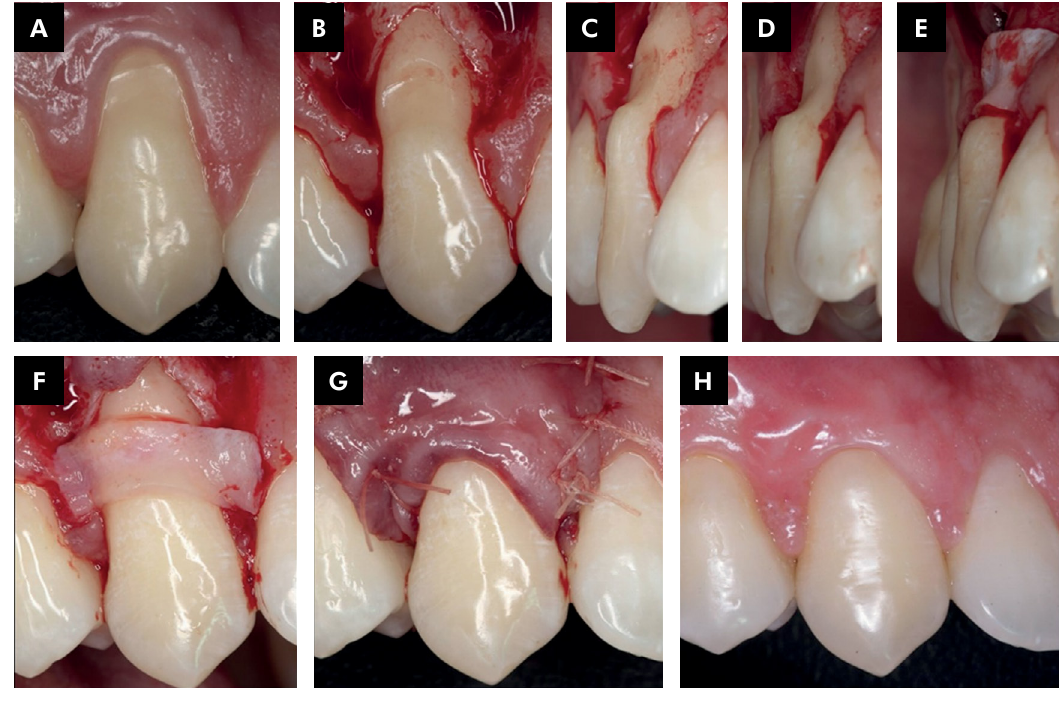
Figure 6. Representative case of A+ combined defect (CD) treated with a coronally advanced flap with connective tissue graft. Buccal view of the CD (a). After flap elevation. Note that the cementoenamel junction is intact with the presence of a step (b); Lateral view of the root defect (c). After scaling and root planing (d), the graft was placed in position (e, f), coronally advanced flap and sutures (g). Outcome after one year